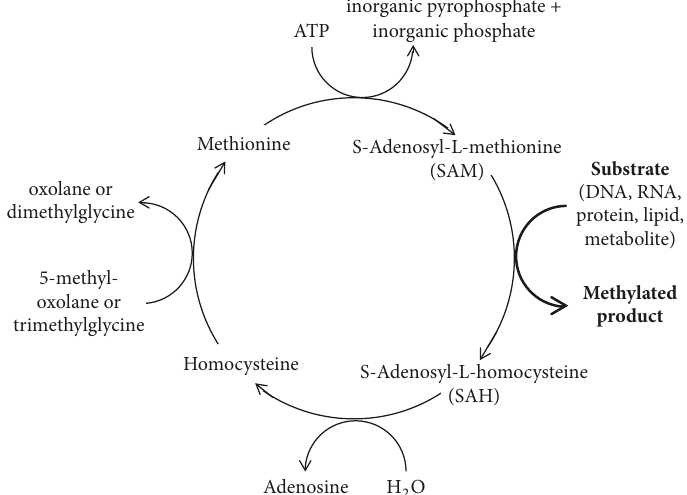
Figure 9: The S-adenosyl methionine cycle.